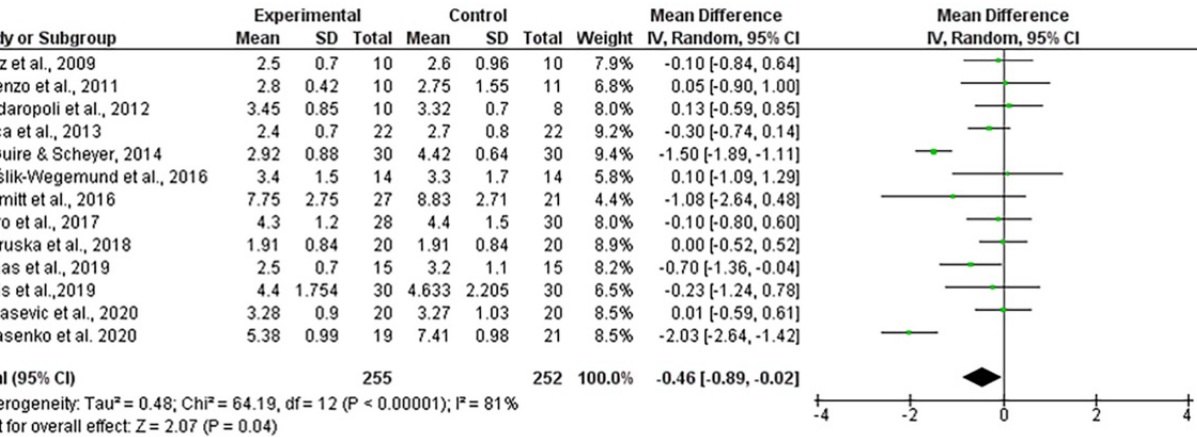
Figure 8. Forest plot for keratinized mucosa width gain. Test (collagen matrix) vs. control (autogenous connective tissue) groups. The weighted mean is presented at CI 95%. Heterogeneity was determined using Higgins (I 2 ). A random-effects model was applied. Statistical significance was p = 0.04.